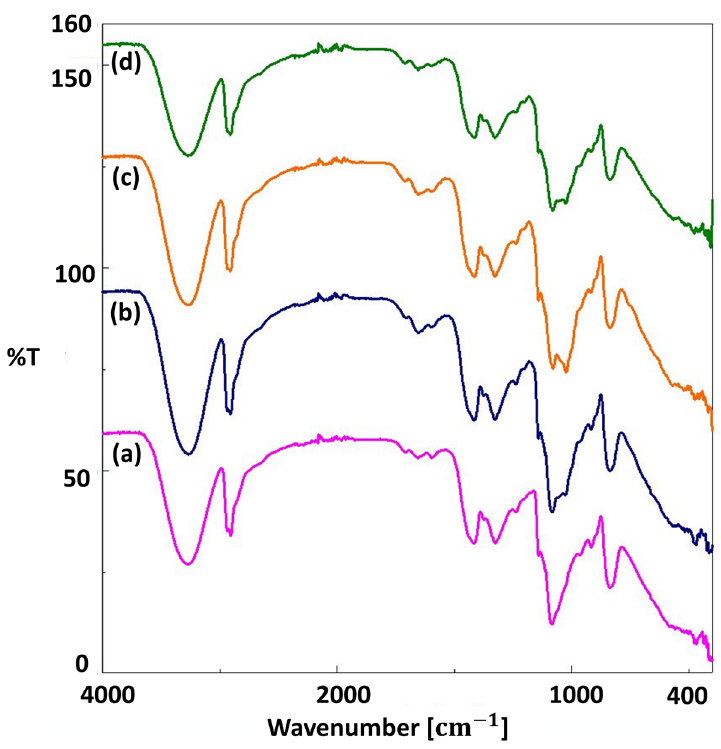
Figure 3. FTIR spectra of the 13% PVA ( a ), 13% PVA/1% S ( b ), 13% PVA/2% S ( c ), and 13% PVA/3% S ( d ).